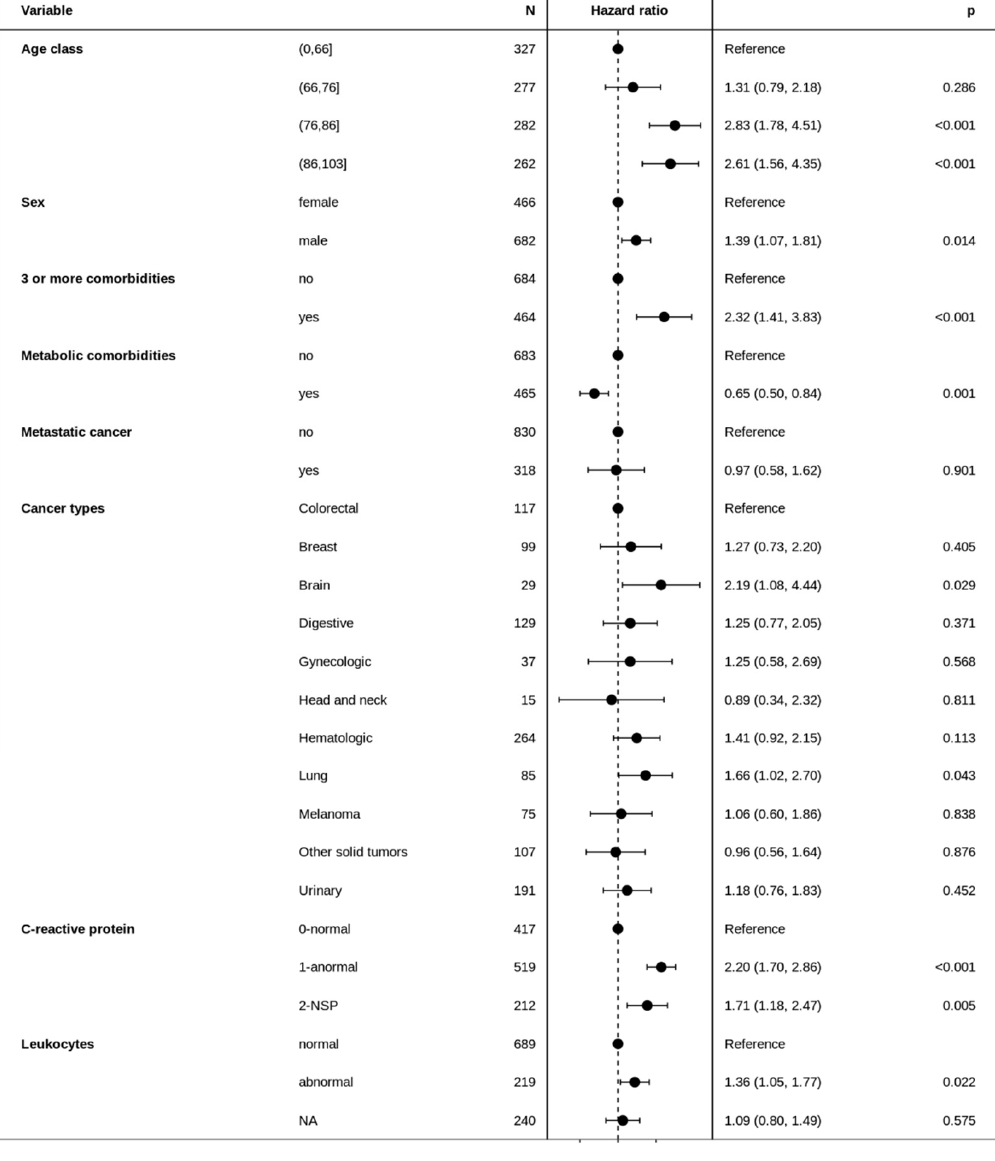
Figure 2. Forest plot of the multivariate analysis of factors associated with all-cause mortality within 30 days of COVID-10 diagnosis. NA/NSP: Not Available.